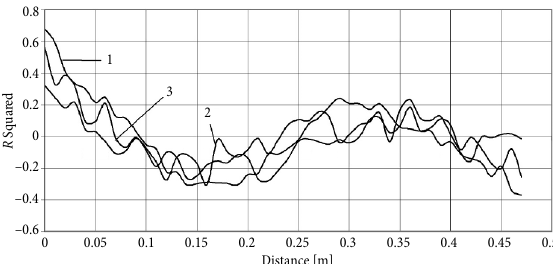
Fig. 4. The square of the Pearson correlation for the asphalt pavement: 1, 2, 3 – road stretches